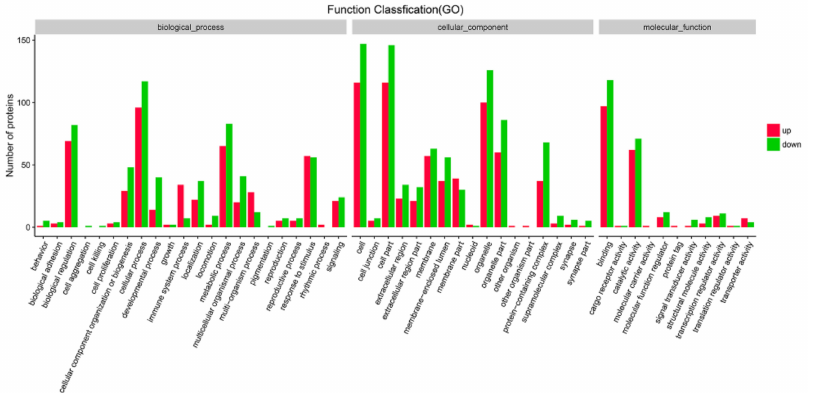
Figure 8. Gene ontology classification of up- and down- regulated proteins in MDBK cells infected with CpHV-1. The differentially expressed proteins (DEPs) were annotated in three categories: biological processes, cellular components and molecular functions. The abscissa represents the GO function classification, and the ordinate represents the number of proteins corresponding to the function. Red bars indicate upregulated proteins, and green bars indicate down-regulated proteins. A detailed representation of the data is provided in Table S6.